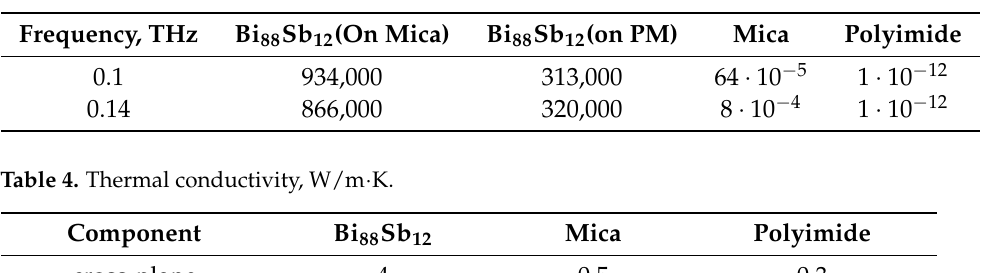
Table 3. Electrical conductivity, real part, S/m.